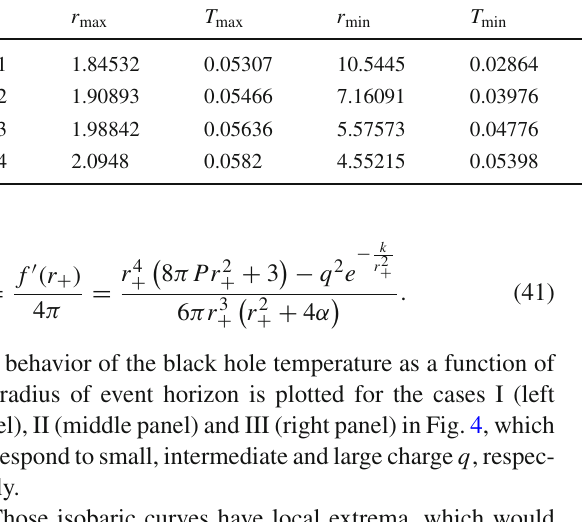
Fig. 4 The isobaric curves in the T − r + diagram are plotted for various values of the charge q and the pressure P , at α = 0 . 5 and k = 0 . 4. The blue, red, and green curves correspond to P = 3 Table 1 The numerical results for the local maximum temperature T max and the local minimum temperature T min corresponding to the radius r max and the radius r min are given in terms of the pressure under various values of Gauss–Bonnet coupling constant α , at k = 0 . 35 and q = α = 0 . 5